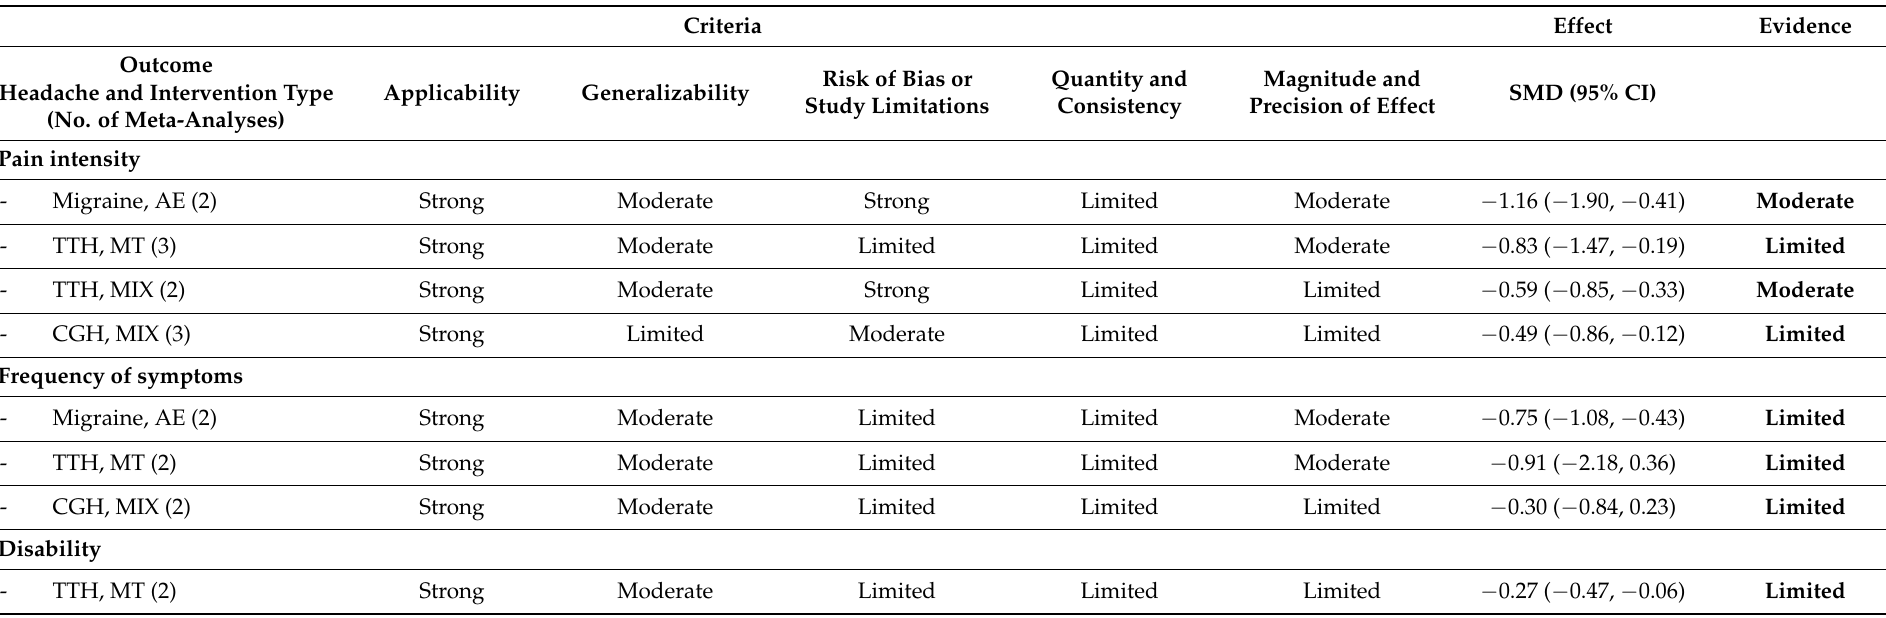
Table 5. Committee assigned grades for the effects of manual therapy or therapeutic exercise on headache-related